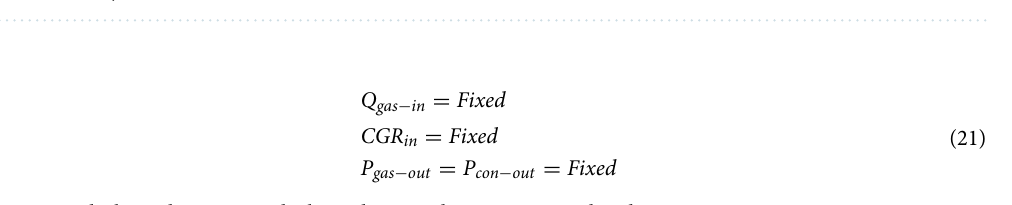
Table 3. Surface tension and viscosities of gas and condensate at the used pressure in the network (at 37 °C) Jamiolahmady et al. 13 .